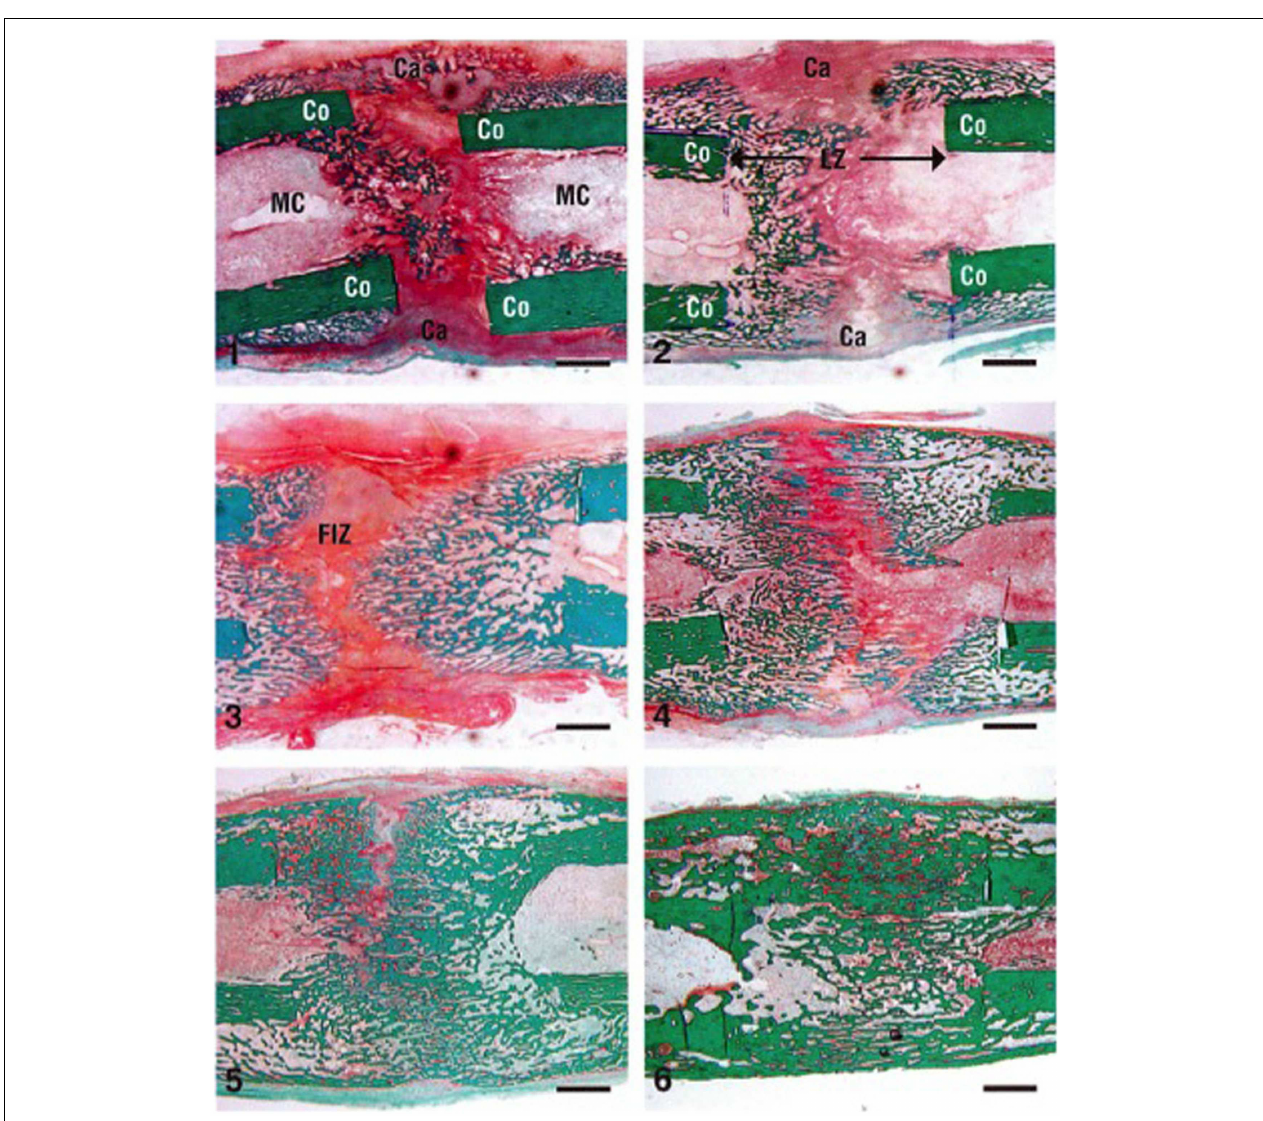
are during the distraction phase and 4–6 are during the consolidation phase). Co, cortex; LZ, lengthened zone; Ca, callus; FIZ, fibrous interzone. Bar scale = 2mm. Reprinted from Rauch et al. (34), with permission from